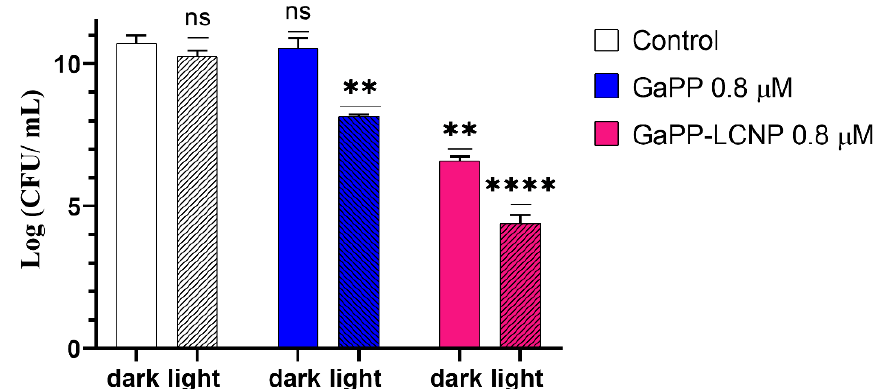
Figure 7. The viability of P. aeruginosa planktonic culture following treatment with GaPP and GaPP- LCNP (0.8 µM), light dose of 17.2 J/cm2, compared to saline treated control in dark. Data presented as mean ± SD, n = 3. ns: non-significant reduction, **** significant reduction in viability, P value < 0.0001, ** P value = 0.001 (Two-way ANOVA fol lowed by Dunnett’s multiple comparison test).